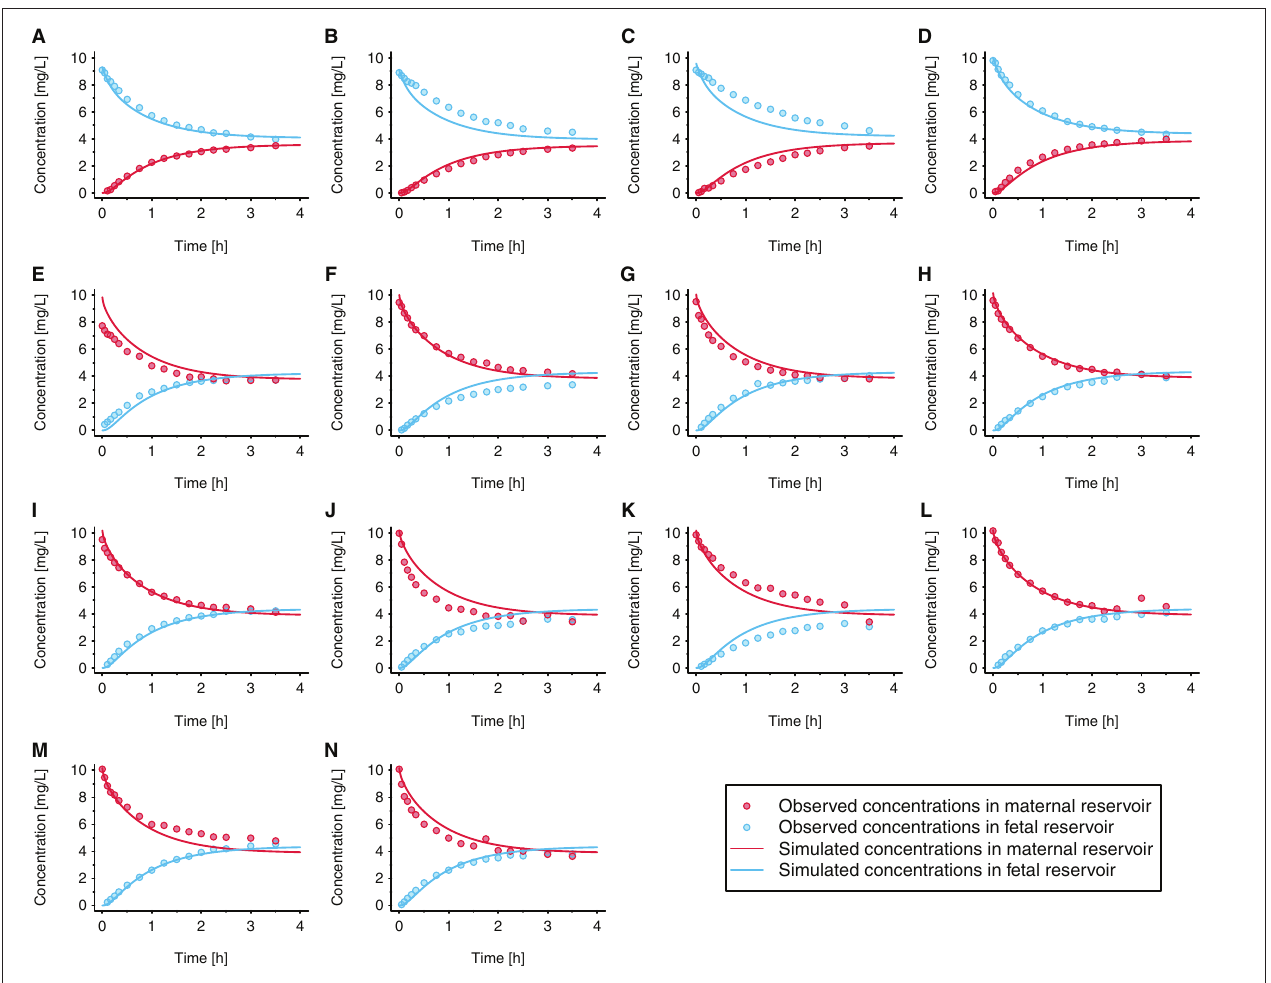
FIGURE 4 | Observed and simulated concentration time profiles in the novel ex vivo cotyledon perfusion model. In each experiment, acetaminophen was either administered to the fetal reservoir (A–D) or maternal reservoir (E–N) at time = 0h. The initial concentration was 10 mg/L in all experiments (to reflect clinically relevant concentrations); each panel refers to an individual experiment. All experiments were conducted under similar conditions. Observed data were taken from Conings et al. (20).